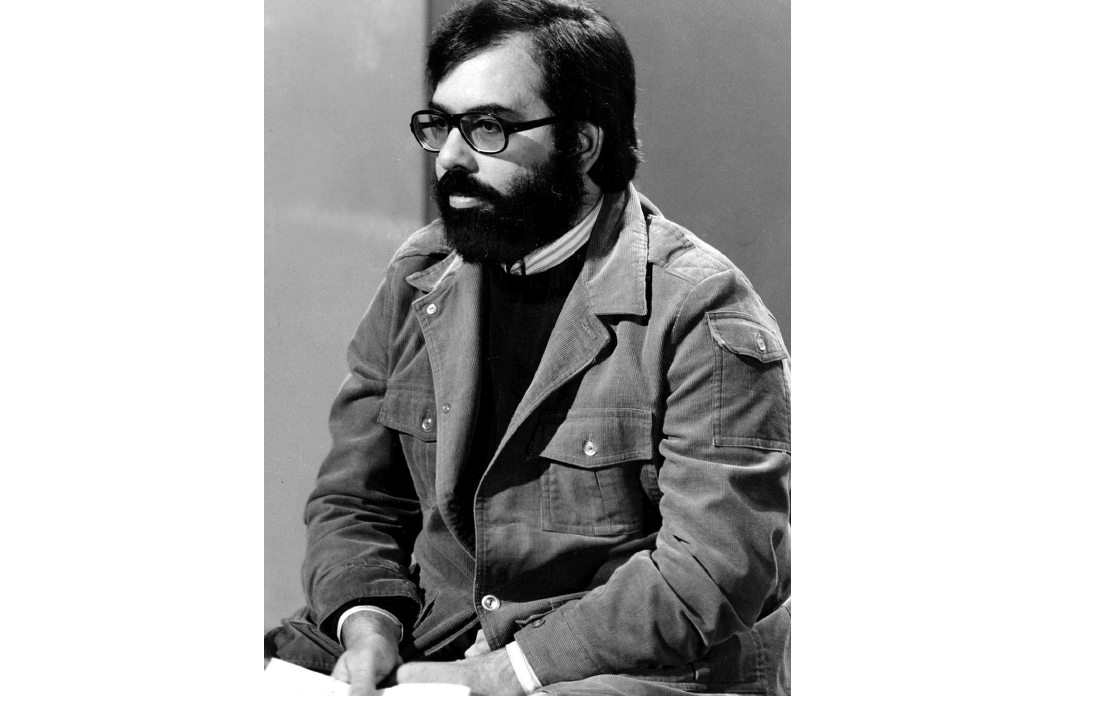
Figure 4. Francis Ford Coppola, seen here in 1976, is the best known and most successful of Arzner’s former students (Source: Wikimedia